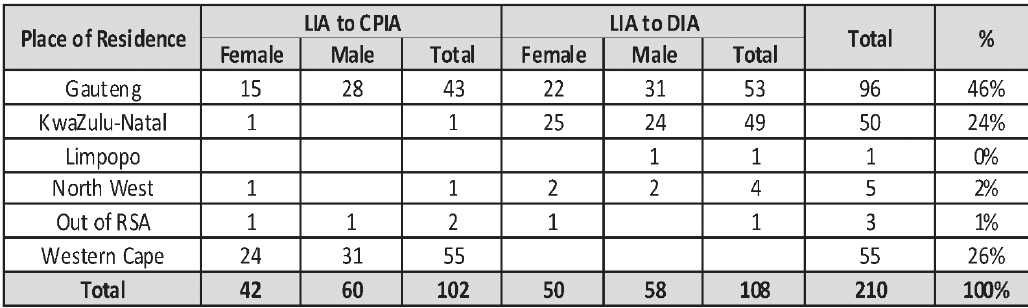
Table 4: Place of residence